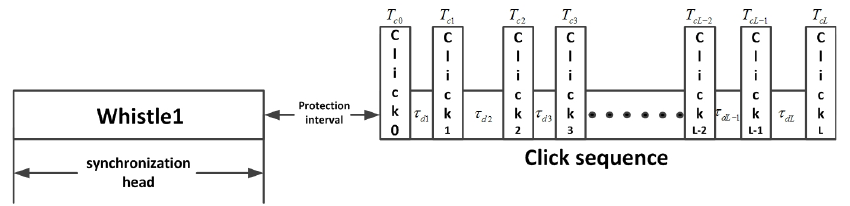
Figure 9. Frame structure of the mimic bio-signal combined with whistle and